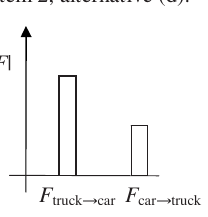
FIG. 2. Corresponding multiple-choice alter- natives of theme 4 (cid:1) T4 (cid:2) in the R-FCI. The repre- sentational formats of the alternatives are a bar chart (cid:1) item 2 (cid:2) , verbal (cid:1) item 11 (cid:2) and vectorial (cid:1) item 20 (cid:2) . All three items include an identical original FCI question in the verbal form. The questions of bar chart and vectorial items include explanation of notations such as F truck → car